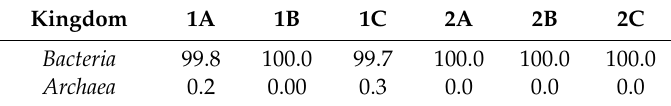
Table 1. Kingdoms distribution in phototrophic biofilms from Nerja Cave.